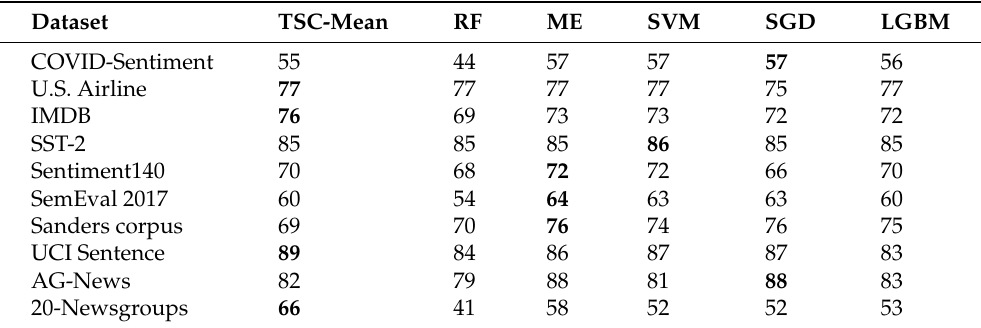
Table 6. SBERT vector-based weighted F1-score (rounded) results for six classifiers. Best results are in bold